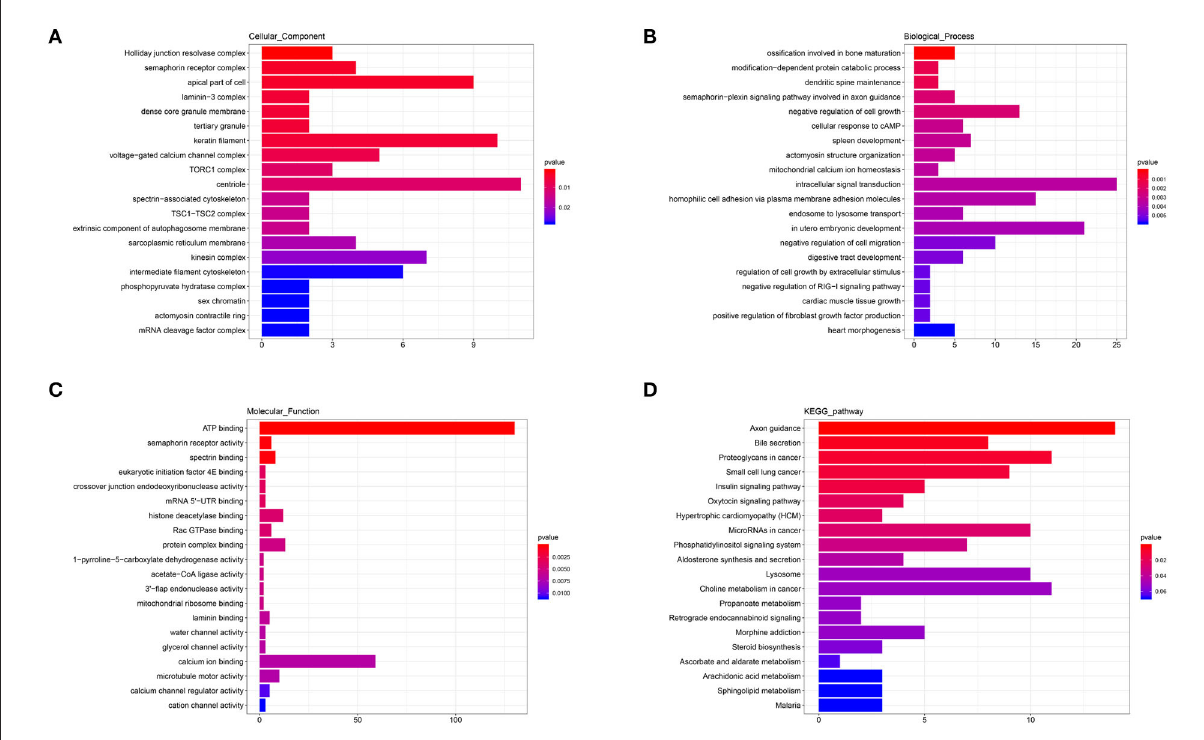
FIGURE7 GO and KEGG analysis of DEmiRNAs. (A) Cellular component enrichment. (B) Biological process enrichment. (C) Molecular function enrichment. (D) KEGG analysis.